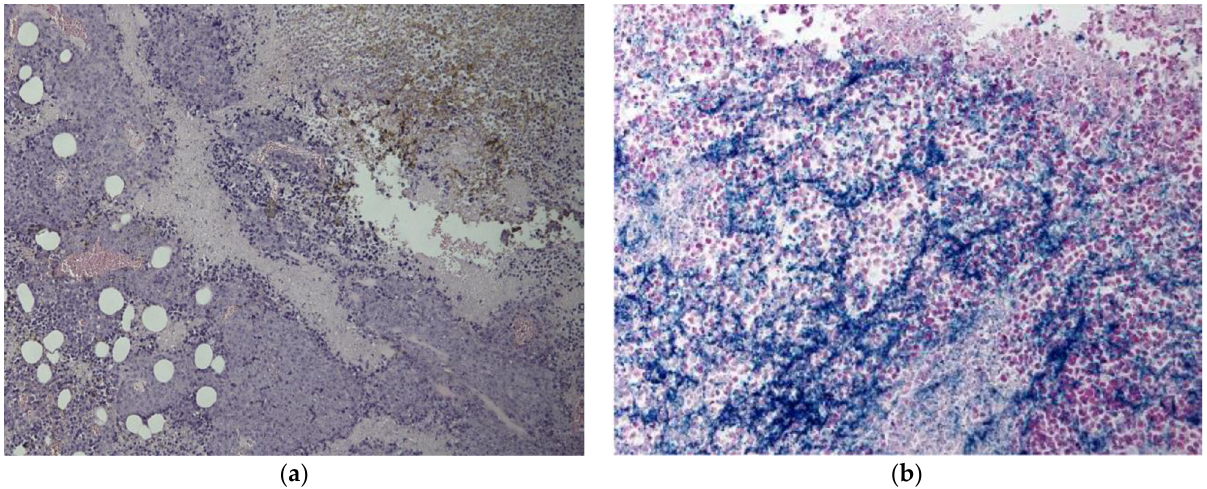
Figure 6. Histological demonstration of significant tumor tissue necrosis (Ehrlich carcinoma) and mNP accumulation in macrophages 24 h after mNP intratumor injection. ( a )—(H&E ×100); ( b )—(Perl’s Prussian blue ×100). Group III mouse.